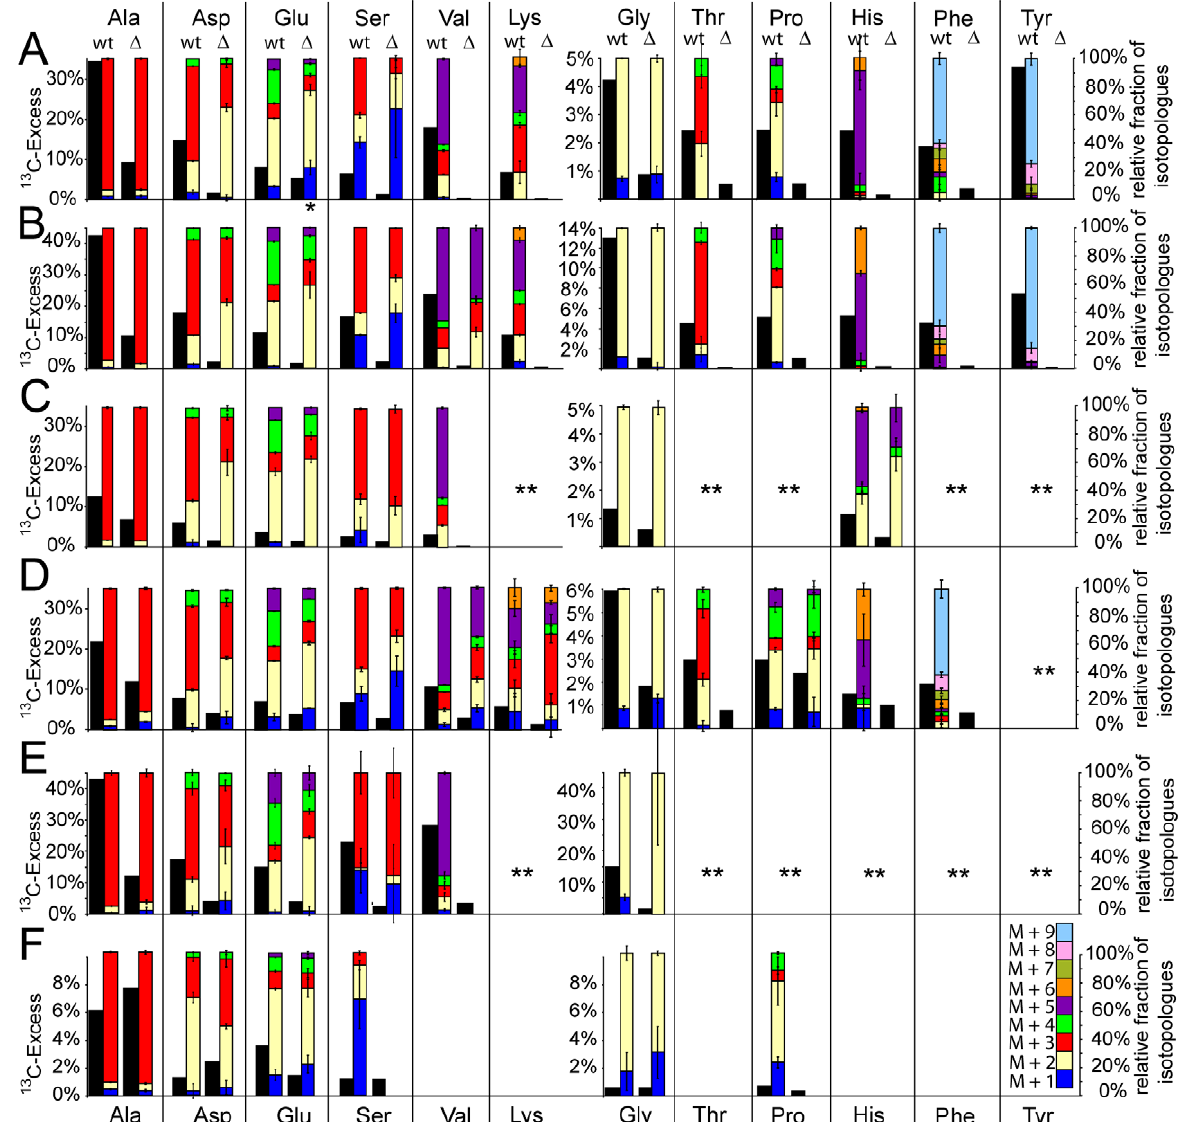
Figure 3. 13 C-Isotopologue distribution in the amino acids denovo synthesised in intracellular EIEC -1 (A), EIEC -2 (C) and Stm (D) replicating in slower proliferating Caco-2 cells as well as EIEC -1 (B) and Stm (E) replicating in faster proliferating Caco-2 cells (see text for details); Caco-2 cells infected with EIEC -1 (F) (coloured bars, see also Table S4). The 13 C-distribution of the glucose-6P uptake mutants is similar to wt and that of the glucose uptake mutant similar to the glucose/glucose-6P uptake mutants ( D ) and therefore not shown (but see Table S4).The coloured boxes indicate the percentage of the 13 C-isotopologues (M + 1 to M + 9) of the different amino acids (right scales). The black bars indicate the overall amount of 13 C-incorporation (in mol%) into amino acids of the wild-type strains (wt) and their corresponding glucose/ glucose-6P uptake mutants ( D ) as well as in the Caco-2 cells, infected with wt and D strains (left scales). Note that two left scales were used in A-F to better differentiate the 13 C-incorporation into the various de novo synthesised amino acids of the three intracellular bacteria and their mutants. * indicates that data from glucose uptake mutant are displayed. ** These data are not shown in the figure due to high standard deviations or missing data points (see Table